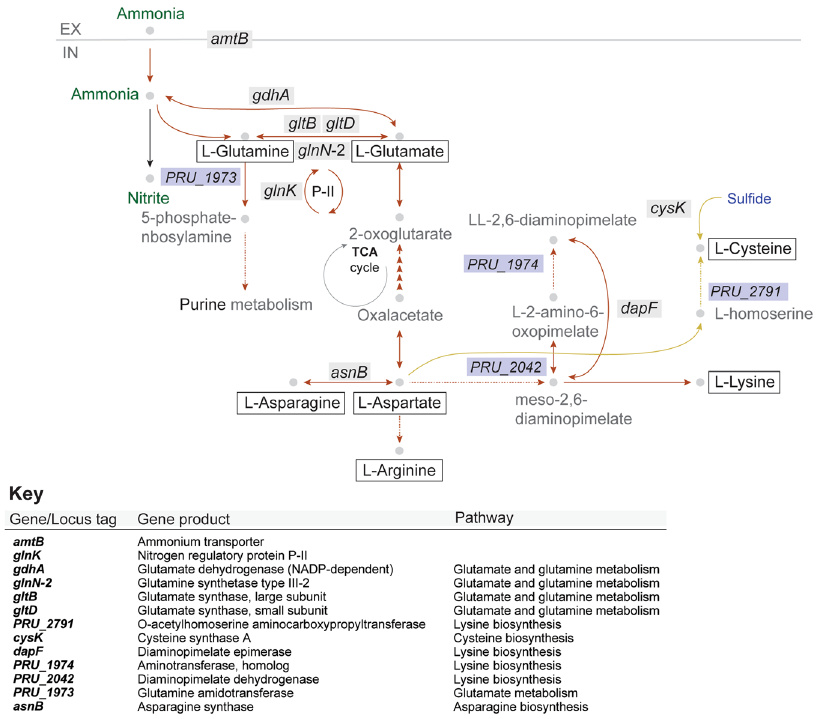
Figure 5. Metabolic networks for nitrogen utilization in Prevotella ruminicola 23. The bacterium can utilize both ammonium and peptides for growth through activation of different biochemical pathways. In contrast to E. coli and Salmonella spp., growth on non-limiting ammonium conditions is maximized by both GDH and GS/GOGAT-dependent ammonium assimilation. Growth on peptides might rely on extracellular hydrolysis and transport of resulting amino acids, or intracellular deamination of imported oligopeptides. High induction of genes involved in cysteine synthesis could indicate generation of labile amino acids in the cell. Chemical/ biochemical species are represented by grey circles. Nitrogen-containing species are represented in green, and sulfur-containing species are depicted in blue. EX and IN stand for extracellular and intracellular cell locations, respectively. Dashed arrows are used for clarity in order to represent that many steps are implicated in the generation of the displayed species. Red arrows represent pathways induced on ammonium and yellow arrows represent pathways induced on